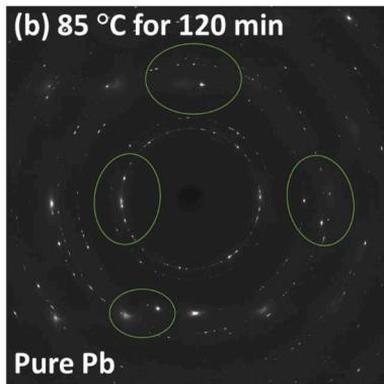
Full Debye-Scherrer rings of the pure Pb foil at 85 ◦C at (a) 0 and (b) 120 min. Some textural changes that occurred in the foil during the temperature hold are highlighted by ellipses. (c) Integrated 1-D diffraction patterns from a pure Pb foil during isothermal holding at 85 ◦C, where only patterns at every 15 min interval are shown.